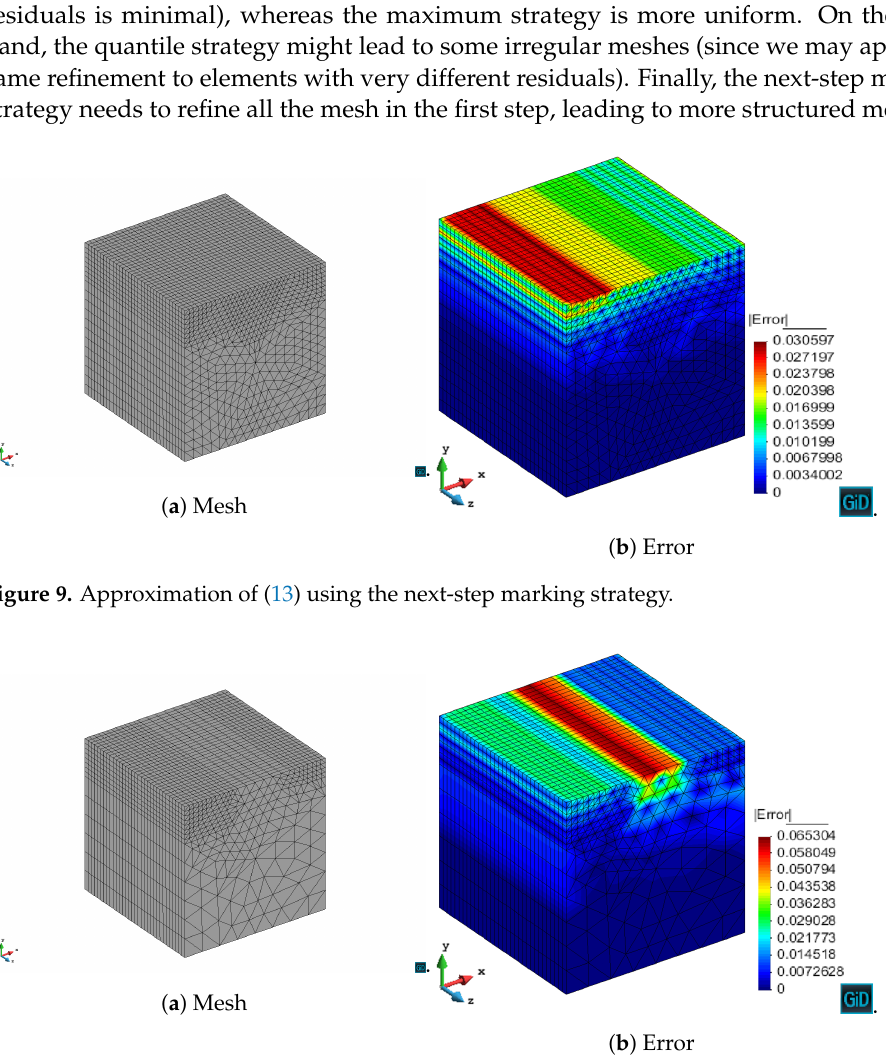
Figure 10. Approximation of (13) using the quantile marking